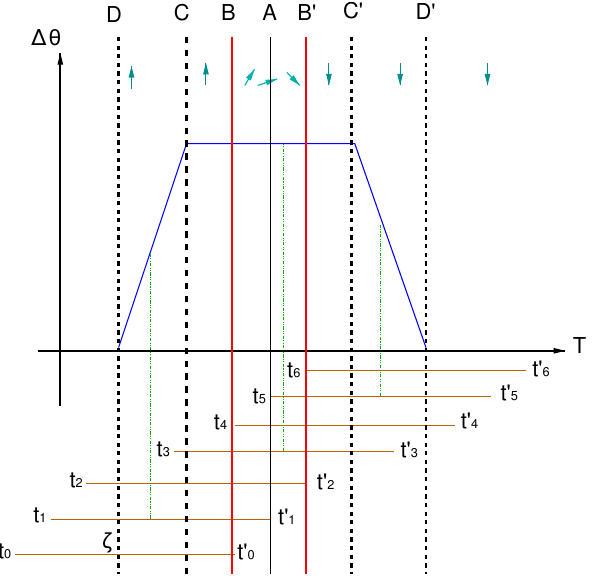
Fig. 3. Cartoon showing the procedure to calculate 1θ(ζ,t) . 1θ(ζ,t) is plotted in 1θ − t plane. The y-axis is 1θ(ζ,t) in de- gree; the x-axis is UT time. The green arrows are the orientation of B vectors. The region from the left side to the red line B is the flux 0 tube 1, which has upright B vector; the region from red line B to the right side is the flux tube 2, which has downright B vector; the 0 region between red lines B and B is the current sheet, in which B vector is changed gradually. The black vertical line A is the center of current